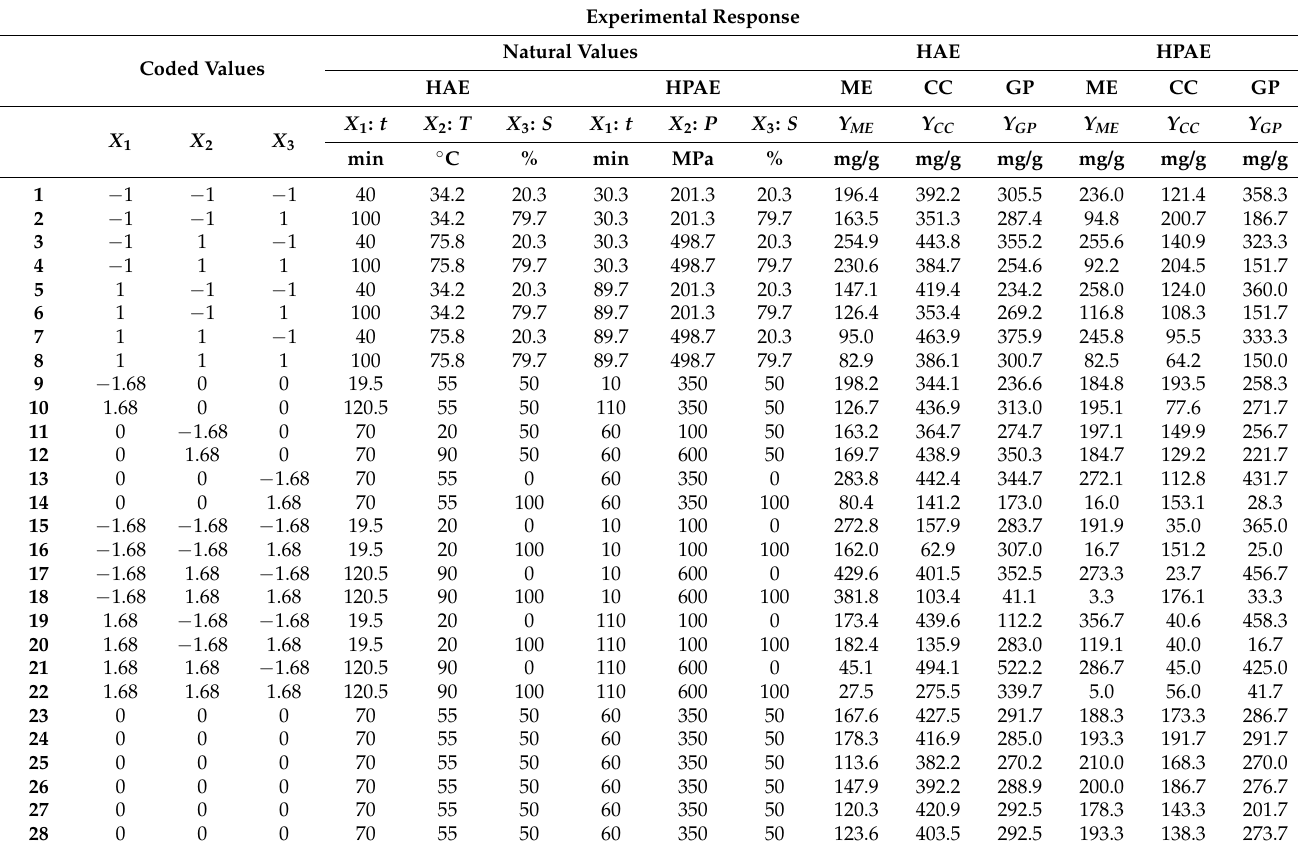
Table 3. Experimental results of RSM of CCCD for the optimization of the three implied variables ( X 1 , X 2 y X 3 ) in HAE and HPAE, for the evaluation of the response in terms of yield (mg of extract per f of alga, mg/g) in the three red algae (ME, CC and GP). The employed variables, natural values and coded ranges are collected in Table